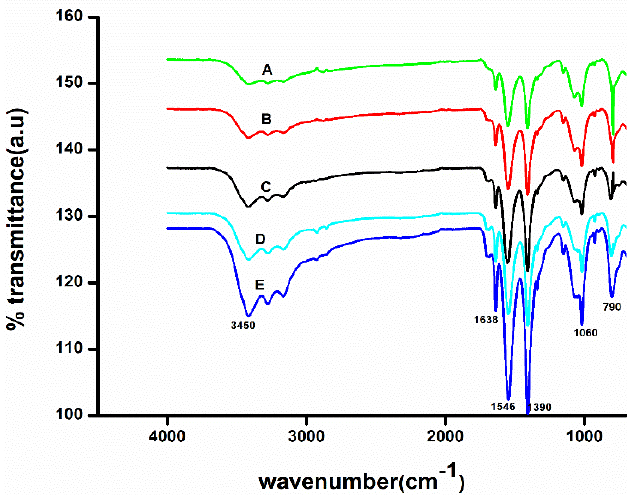
Figure 3. Fourier transform infrared (FTIR) spectra of (A) CH scaffolds (Cp) (B) CH plasticized scaffolds (Cp1) (C) CH plasticized- and surfactant-added scaffolds (Cp2) (D) Cp2+.002 AgNPs (Cp5) (E) Cp2+.0025 AgNPs (Cp6).